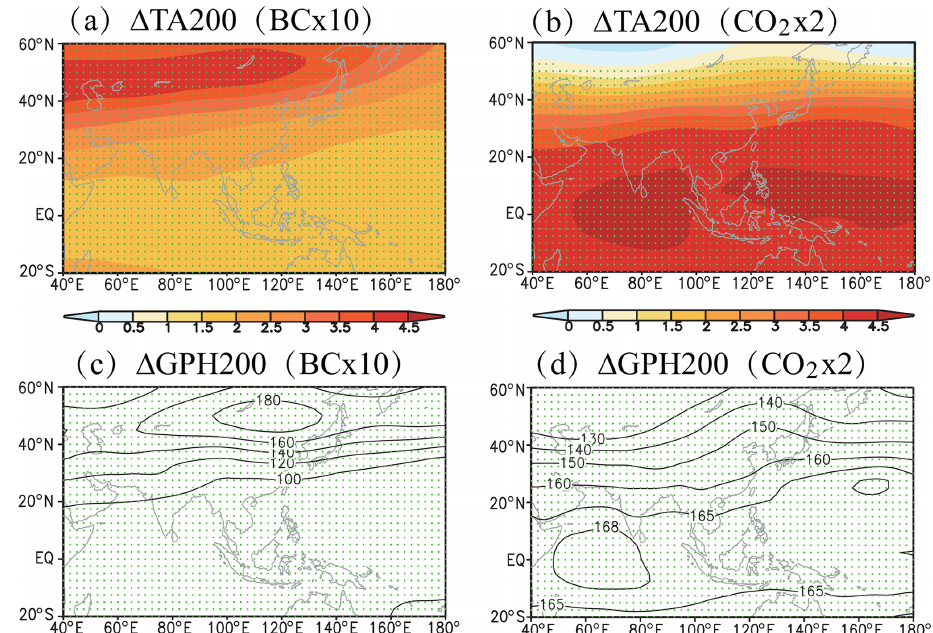
Figure 10. Changes in (a, b) multimodel mean (MMM) of the MJJAS 200hPa atmospheric temperature ( (cid:49) TA200; unit: ◦ C) and (c, d) 200hPa geopotential height ( (cid:49) GPH200; unit: gpm) under increasing BC and GHGs. Dotted regions indicate where the MMM is more than 1 standard deviation away from 0.